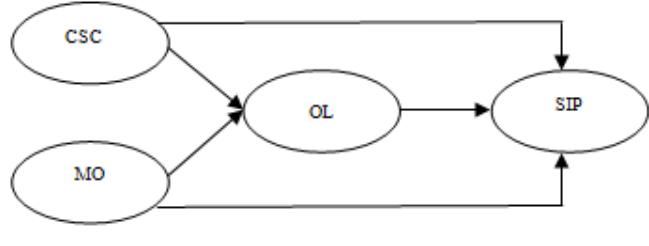
Figure 1. Research